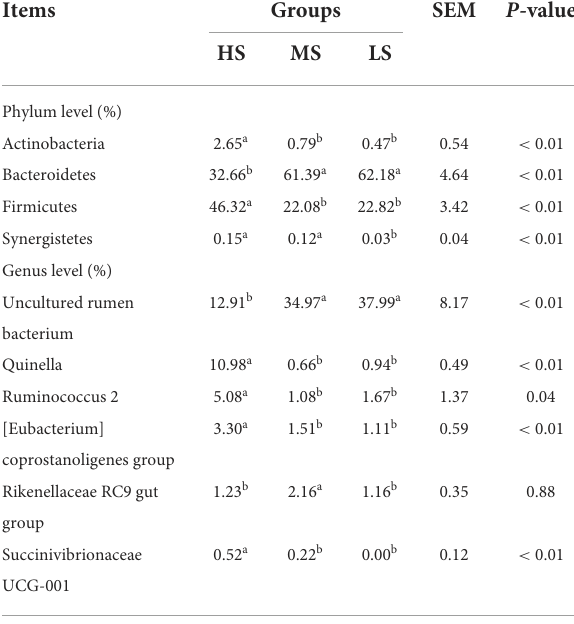
TABLE 9 The main differential rumen bacteria at the phylum and genus levels among the three groups (accounting for the relative abundance in top